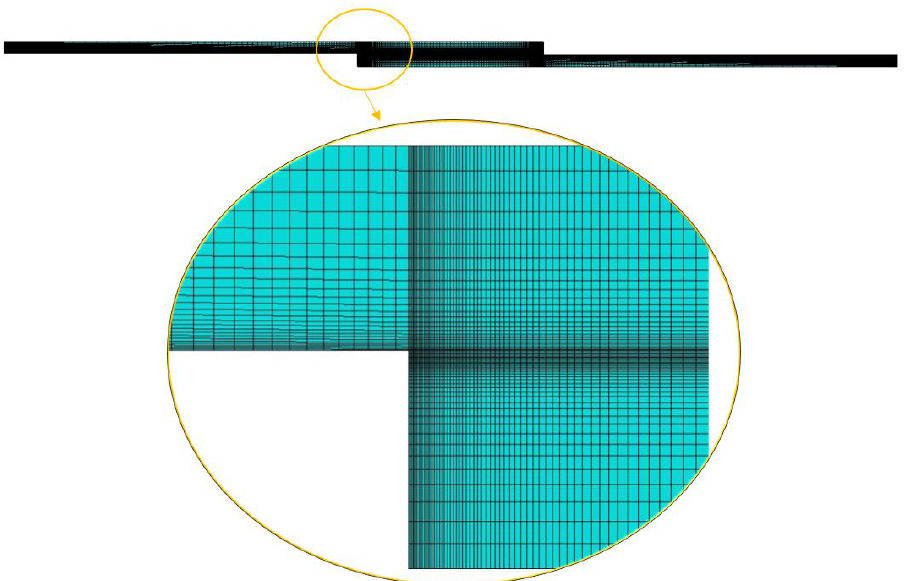
Figure 3. Geometry and mesh of the elastic model.